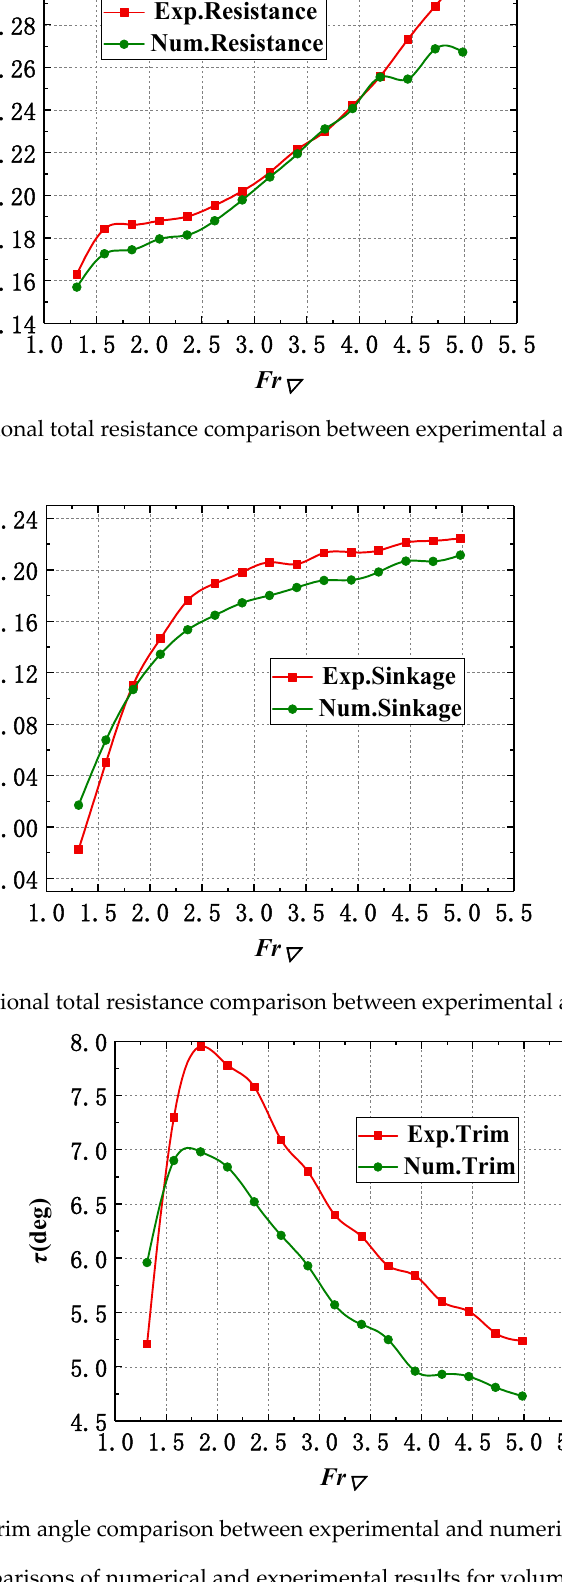
Figure 10. Comparisons of numerical and experimental results for volume Froude numbers ranging from 1.31 to 4.98.